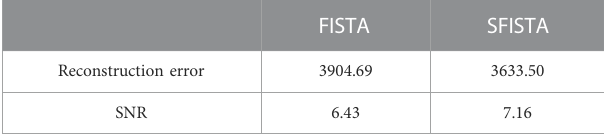
TABLE 5 Reconstruction error and SNR of different